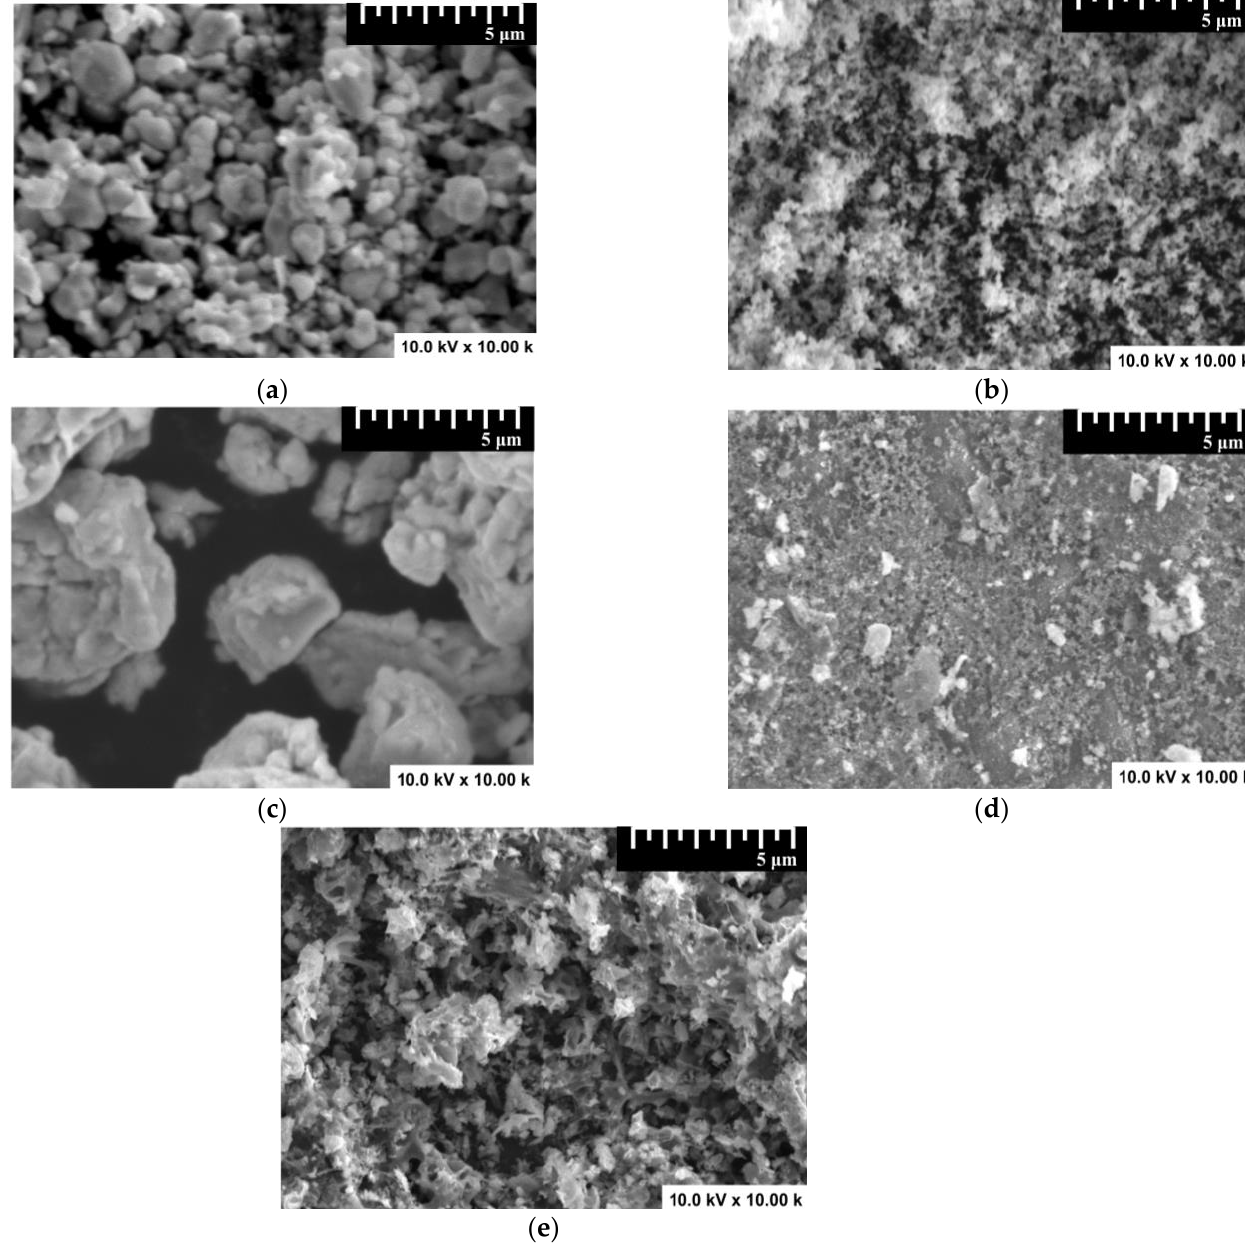
Figure 2. Scanning electron microscopy (SEM) images of the photocatalysts: ( a ) WO 3 , ( b ) SnO 2 , ( c ) Cu 2 S, ( d ) Cu 2 S/WO 3 , and ( e ) Cu 2 S/SnO 2 .